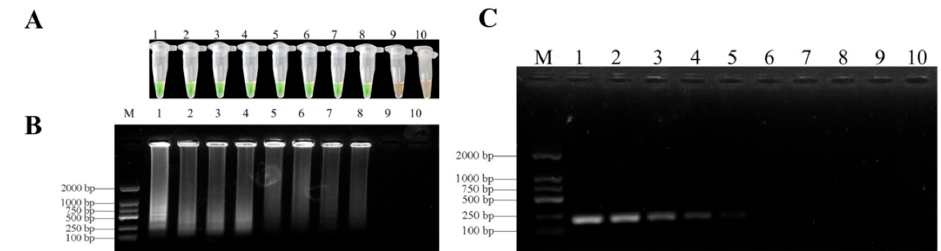
Figure 6. Sensitivity of LAMP and conventional PCR for detection F. oxysporum genomic DNA. ( A ) = Detection by LAMP with SYBR Green I staining; ( B ) = LAMP products analyzed by agarose gel electrophoresis; ( C ) = conventional PCR ana- lyzed on gel electrophoresis. The sensitivities of these assays were evaluated using serially diluted genomic DNA as fol- lows: 1, 50 ng/ μ L; 2, 5 ng/ μ L; 3, 0.5 ng/ μ L; 4, 50 pg/ μ L; 5, 5 pg/ μ L; 6, 0.5 pg/ μ L; 7, 50 fg/ μ L; 8, 5 fg/ μ L; 9, 0.5 fg/ μ L; 10, negative control. M, DL 2000 DNA marker.